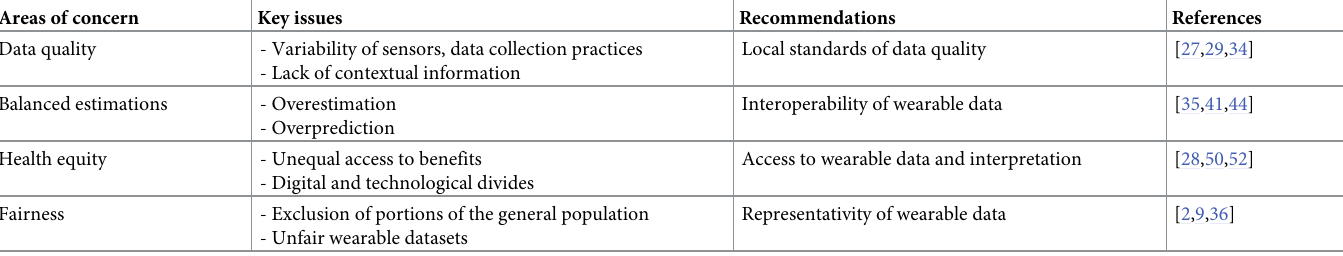
Table 2. Summary of the identified areas of concern and key issues and proposed recommendations. Areas of